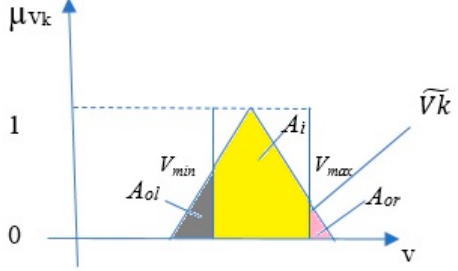
Figure 2. Graphical representation of the voltage of a node as a triangular fuzzy number .